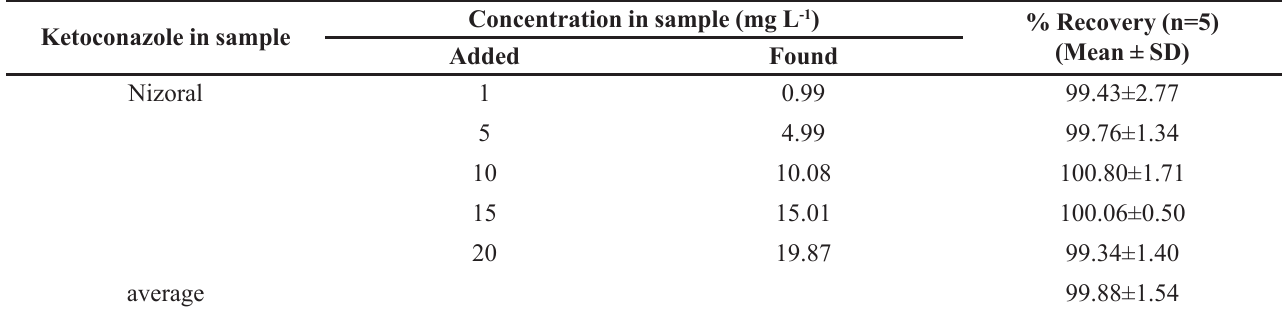
TABLE III - Recovery studies on ketoconazole (Nizoral sample) Ketoconazole in sample